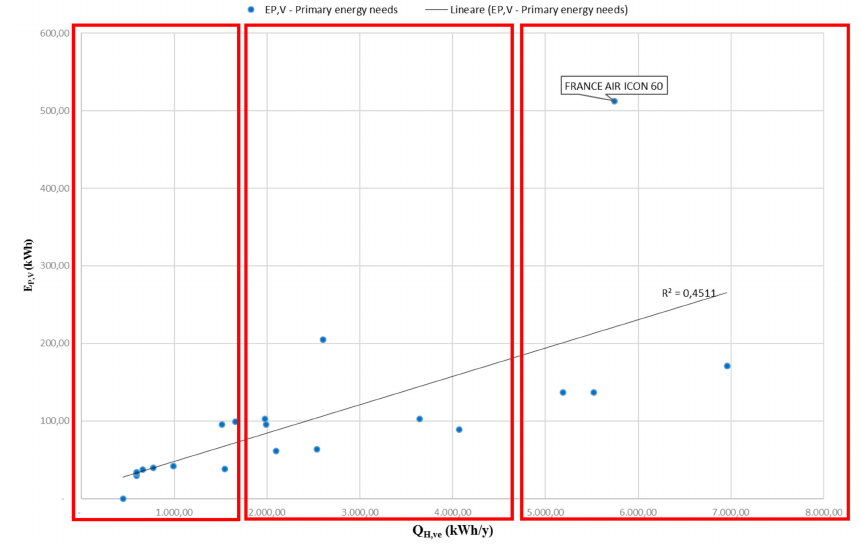
Figure 12. Relationship between Q H,ve and E P,V . NB: all the figures use dots and commas as per Italian